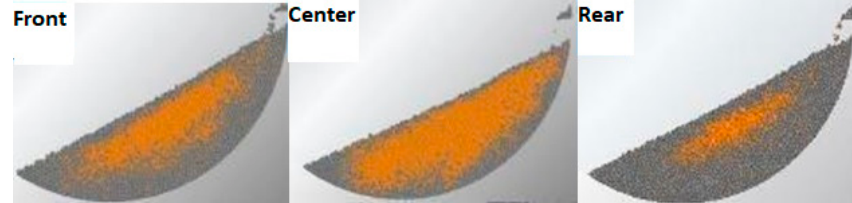
Figure 8. The simulated beads distributions after 2 min (6 revolutions) of mixing for the bi-size bed (drum filled at ¼, 4 baffles of 1.5 cm), from the left to right: front layer, center layer, rear layer.